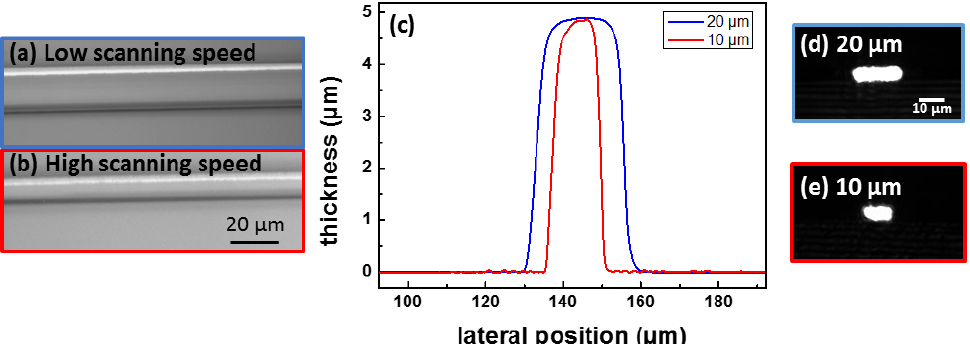
Figure 4. Microscope observation (top view) obtained in reflection mode ( × 63) for ( a ) a waveguide written using a low scanning speed (lateral dimension = 20 µ m) and ( b ) a higher scanning speed (lateral dimension = 10 µ m). ( c ) Corresponding profilometer measurements. Output light distribution at 638 nm for the ( d ) 20 µ m and ( e ) 10 µ m waveguides, respectively. In any case, the blue line is related to the 20 µ m waveguide in width while the red color refers to the 10 µ m one.